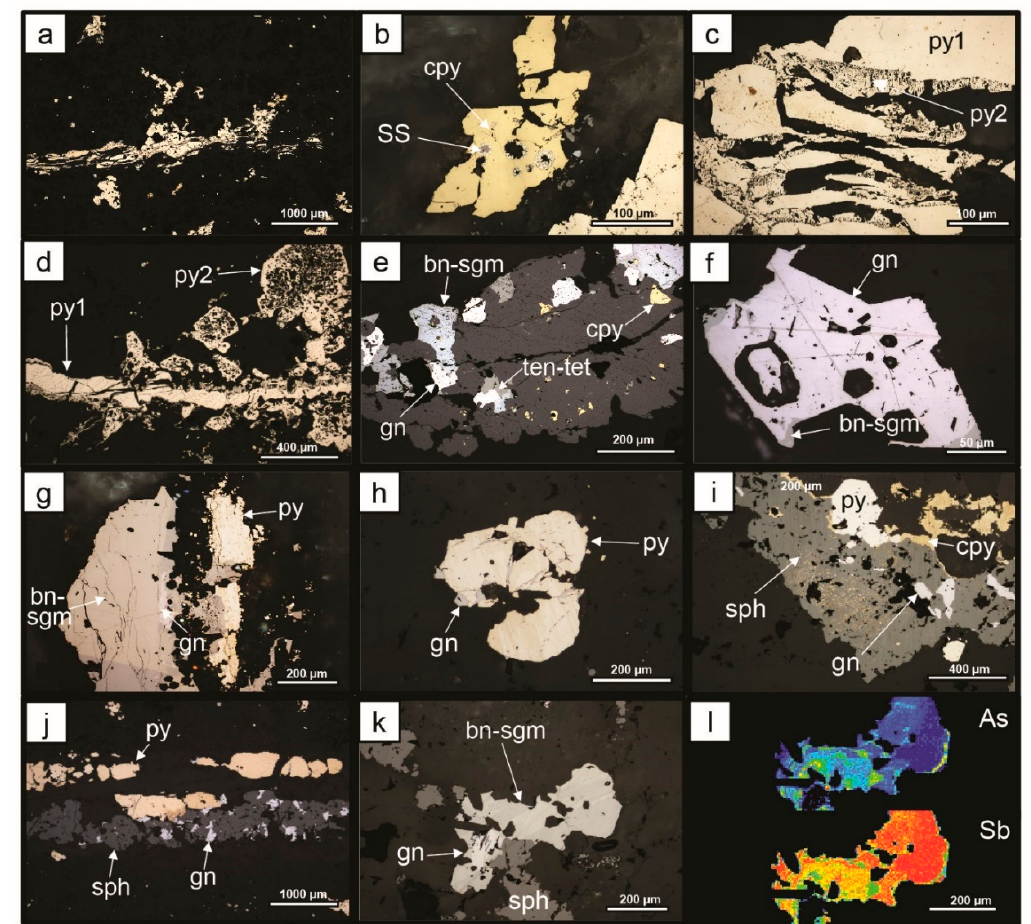
Figure 6. Mineralization in Busang samples. ( a ) Fractured early pyrite (py1) with minor chalcopyrite (cpy) in stockwork veinlets with a second generation of pyrite (py2) occurring as a skeletal overgrown on py1. ( b ) Magnified view of image “a” showing a chalcopyrite clot with poly-phase inclusions including pyrite, and an unclassified Fe-As-Cu-S sulfosalt (SS). ( c ) Magnified view of image “a” with fractured py1 with a skeletal overgrowth of py2. ( d ) Py1 veinlet with an overgrowth of py2 with a euhedral morphology and abundant silicate inclusions. ( e ) Polymetallic sulfide seam with sphalerite (sph) galena (gn), seligmannite-bournonite (bn-sgm), tennantite-tetrahedrite (ten-tet), and chalcopyrite in a quartz-carbonate vein; ( f ) Galena grain partially replaced by seligmannite-bournonite in quartz veins; ( g ) Clot of seligmannite-bournonite, galena, and pyrite in a quartz vein. ( h ) Rounded pyrite clot with galena-filled fractures. ( i ) Sulfide-seam in quartz-carbonate vein. Euhedral py (py2?) overgrown by chalcopyrite, sphalerite, and galena. Sphalerite here has abundant chalcopyrite disease. ( j ) Sulfide seam with early fractured pyrite, sphalerite, and galena in a quartz-carbonate vein. ( k ) Seligmannite-bournonite which has partially replaced galena. ( l ) EMPA element maps of the seligmannite-bournonite shown in “k” for arsenic (As) and antimony (Sb). Warm colors indicate higher abundances.